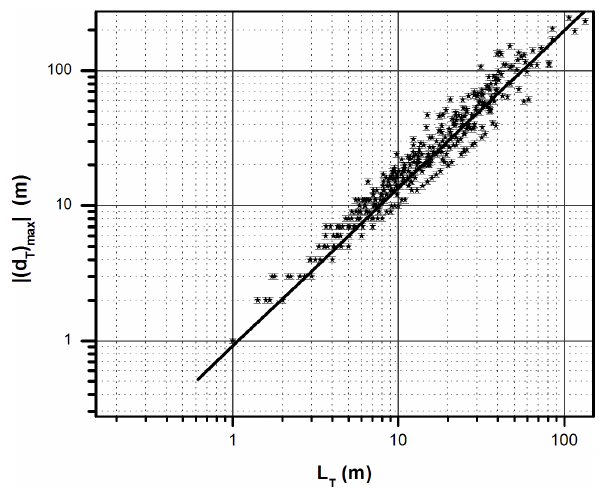
Figure 6. Absolute value of the maximum Thorpe displacement versus the Thorpe scale for the nighttime data set ( ◦ ). The linear fit is indicated by the continuous black